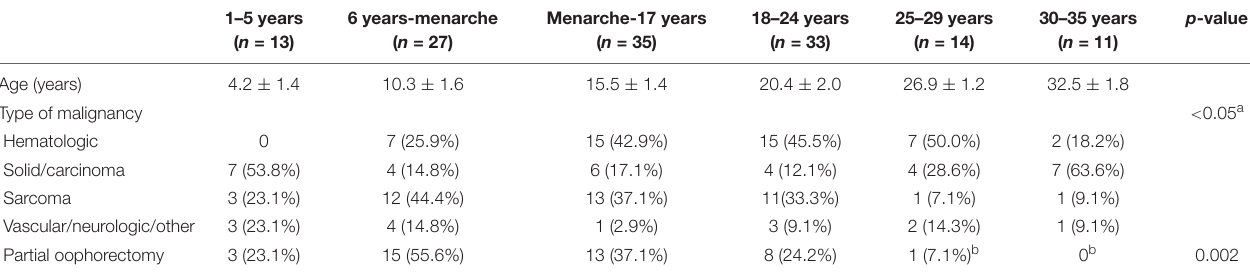
TABLE 1 | Comparison of basic characteristics of the study population according to age groups ( n = 133).